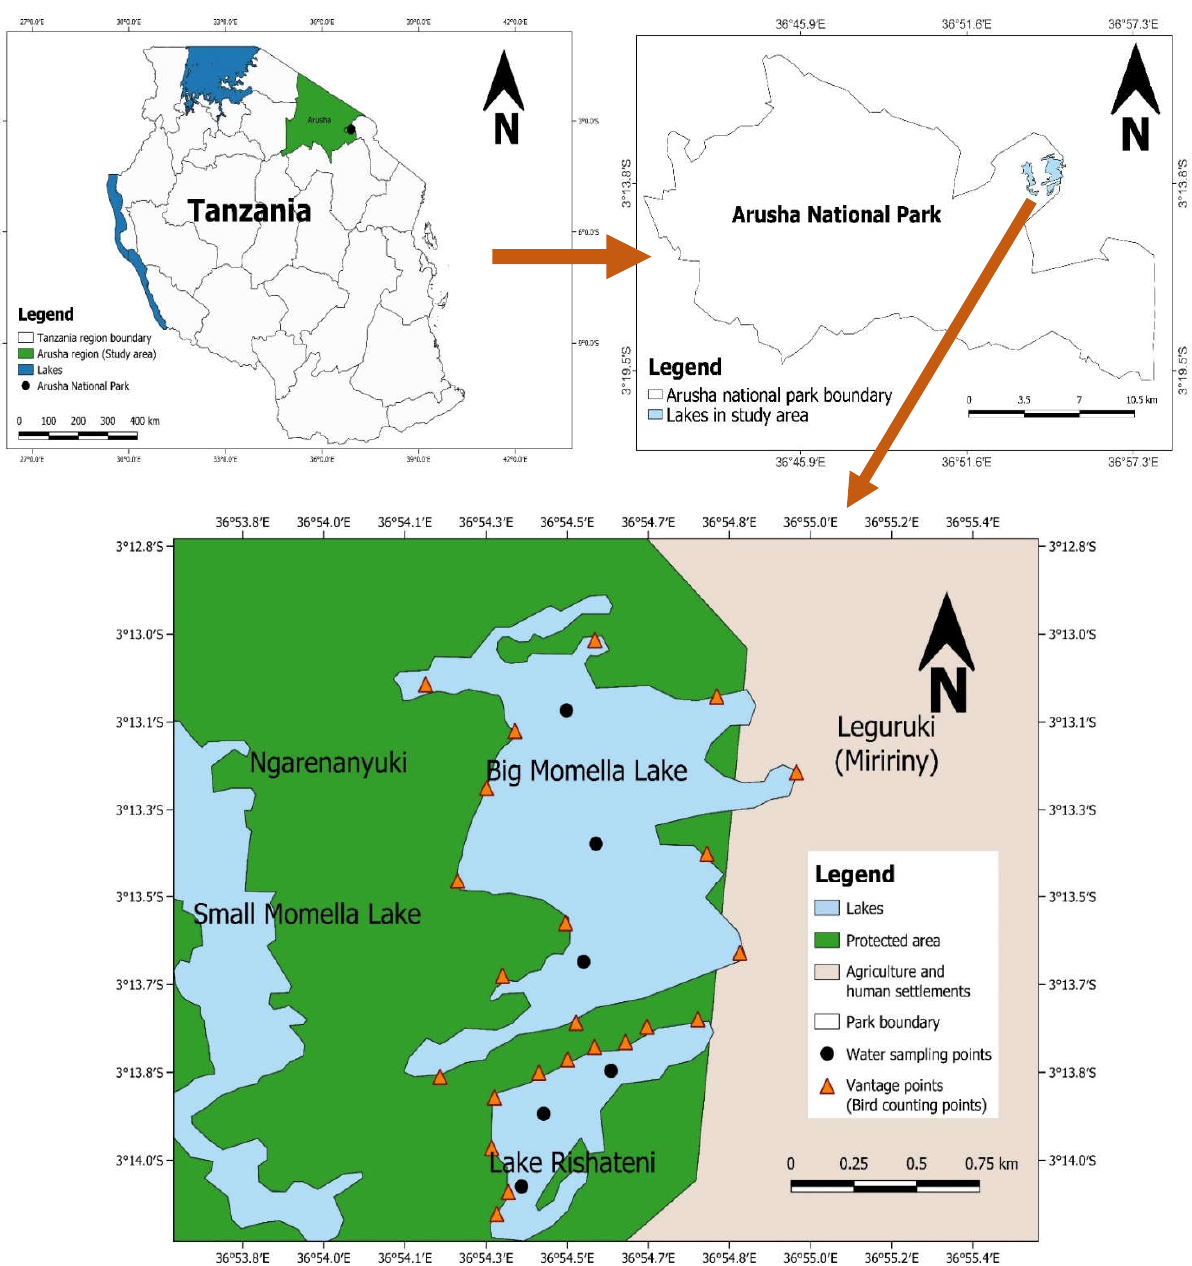
Figure 1. Locations of the lakes Big Momella and Rishateni, at the boundary of Arusha